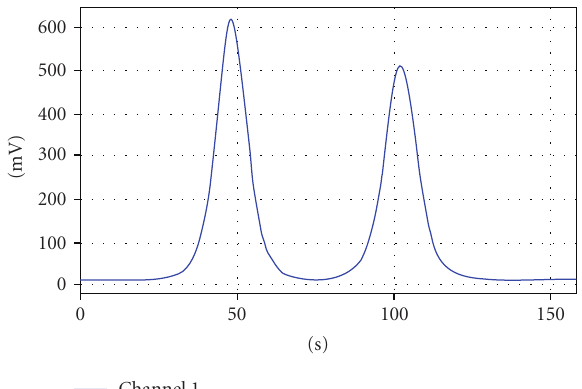
Figure 3: Signal response for sinker movement between detection coils.